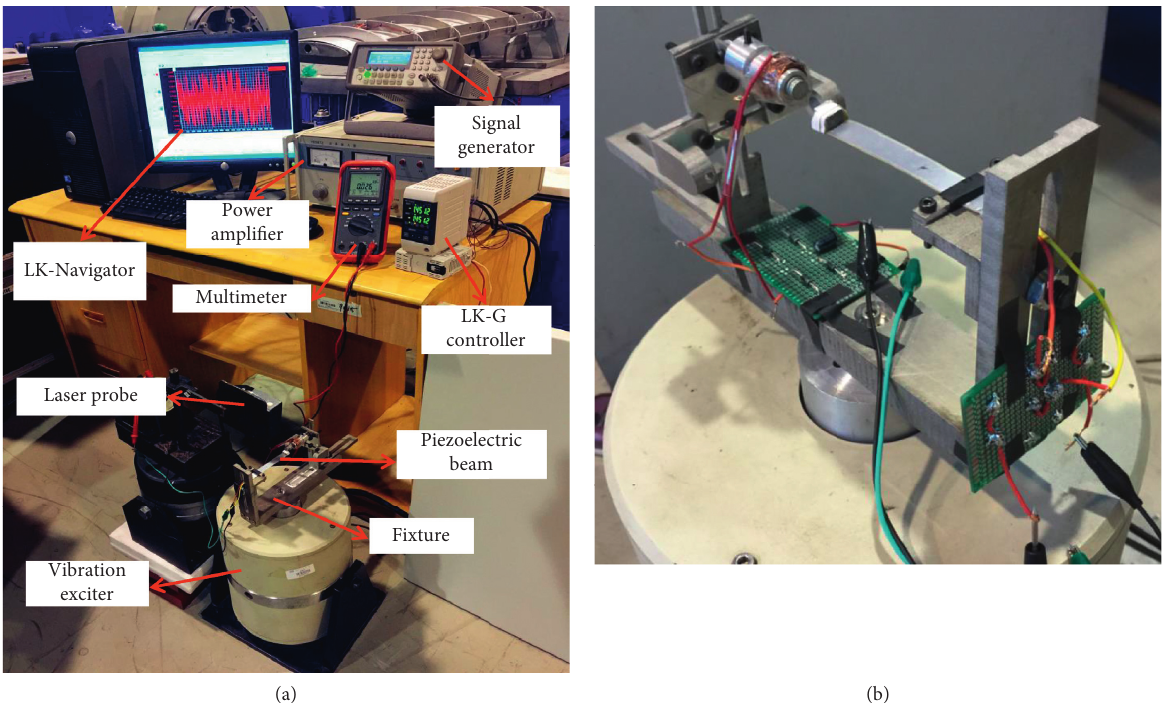
Figure 1: Experimental setups: (a) experimental apparatus; (b) experimental fixture and circuit.